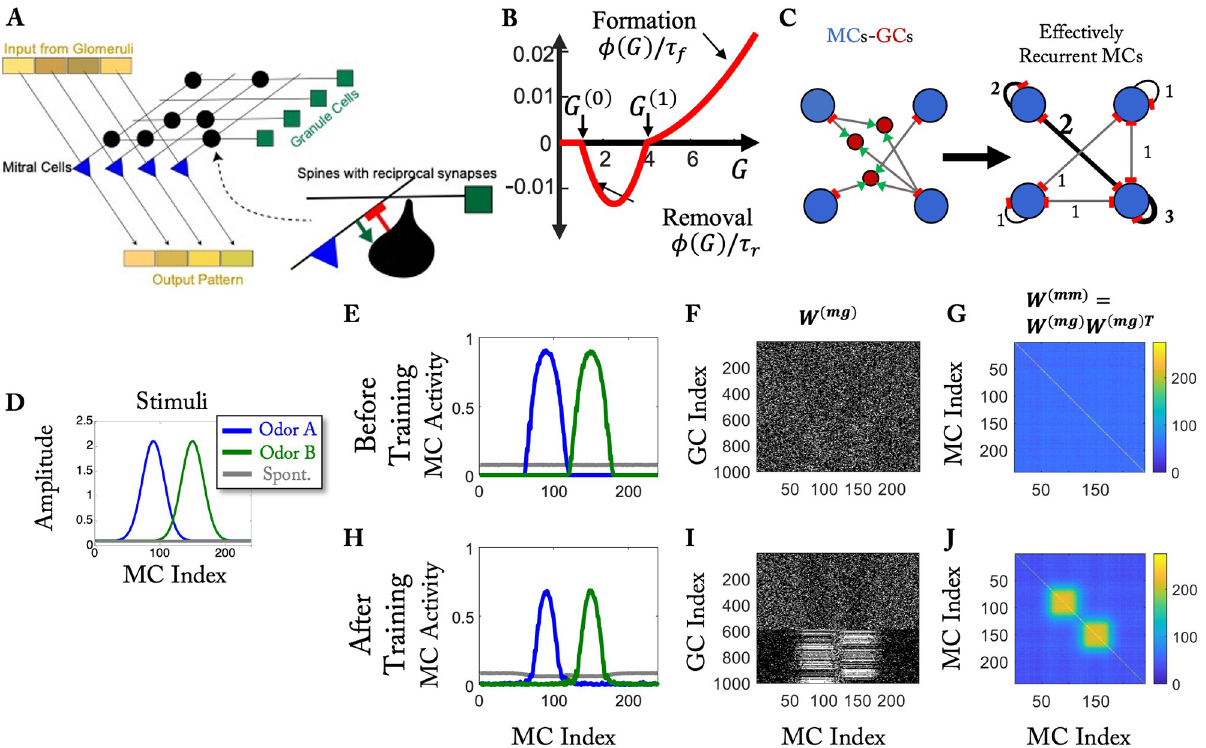
Fig 1. Computational model. (A) Sketch of the network. All spines provide reciprocal synapses that excite GCs (green arrow) and inhibit MCs (red bar). (B) Spine formation is controlled by R = M f ( G ). The figure shows f / τ f for f > 0 and f / τ r for f < 0 (cf. Eq 5). (C) Disynaptic recurrent inhibition of MCs via GCs. The numbers in the right panel indicate the strength of the effective inhibition. (D) Simplified training stimuli. (E, H) MC activity before and after training, respectively. (F, I) Connectivity between MCs and GCs before and after training, respectively. Each white dot represents a connection between an MC and a GC. (G, J) Effective recurrent connectivity among MCs. The color represents the number of GCs that mediate the mutual disynaptic inhibition of MCs via GCs (cf. C).